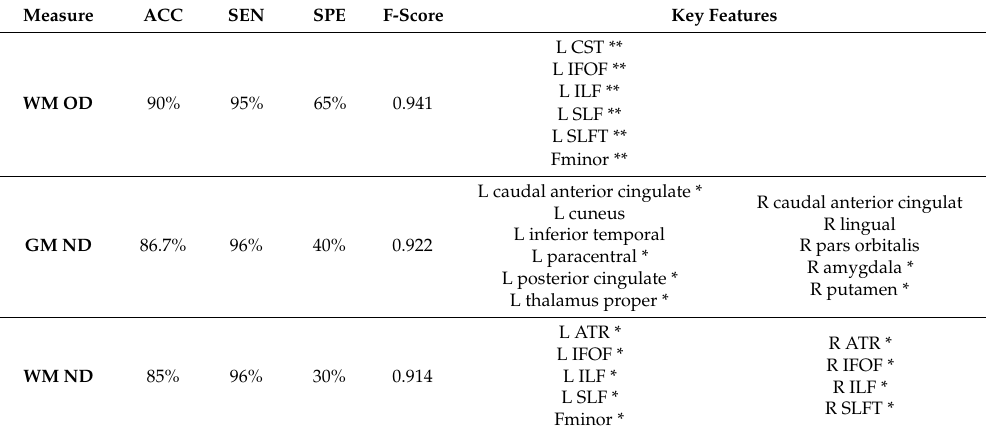
Table 2. Summary of classification performances and feature